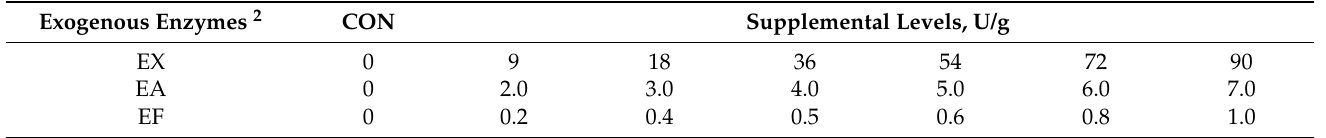
Table 2. Supplemental levels of single-factor experimental parameters (xylan-degrading enzymes) added to corn arabinoxylan 1 .